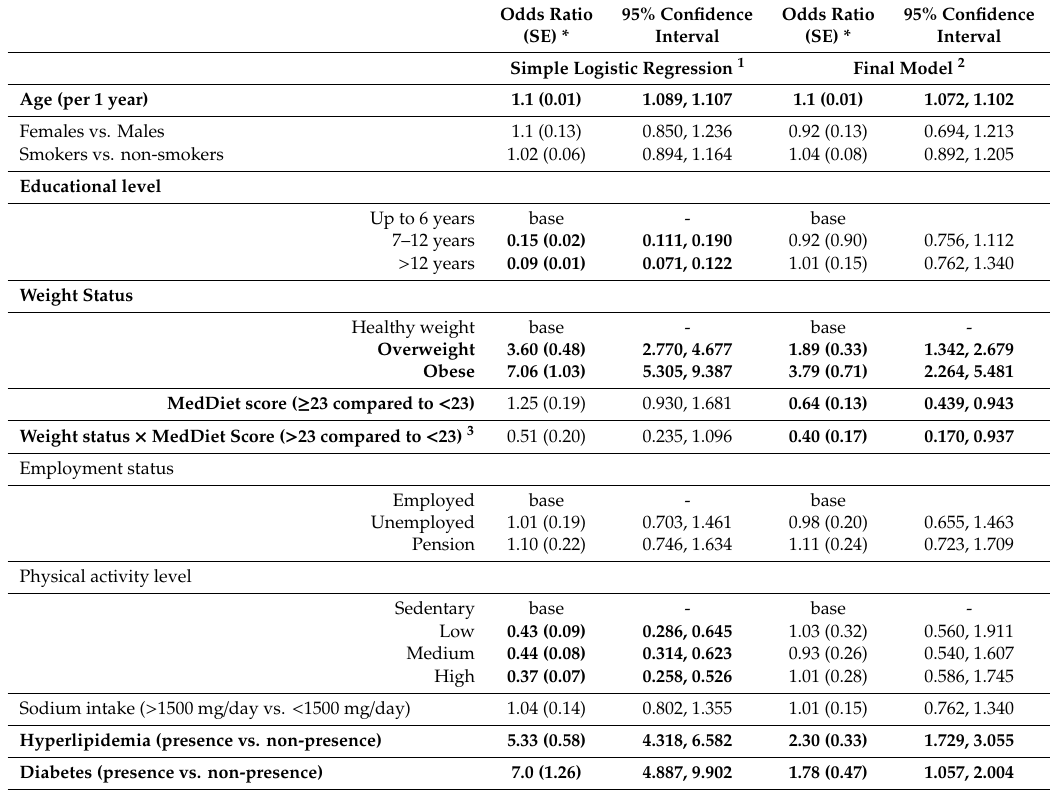
Table 3. Simple and multiple logistic regression analyses, evaluating the odds of hypertension by socio-demographic, lifestyle and biological